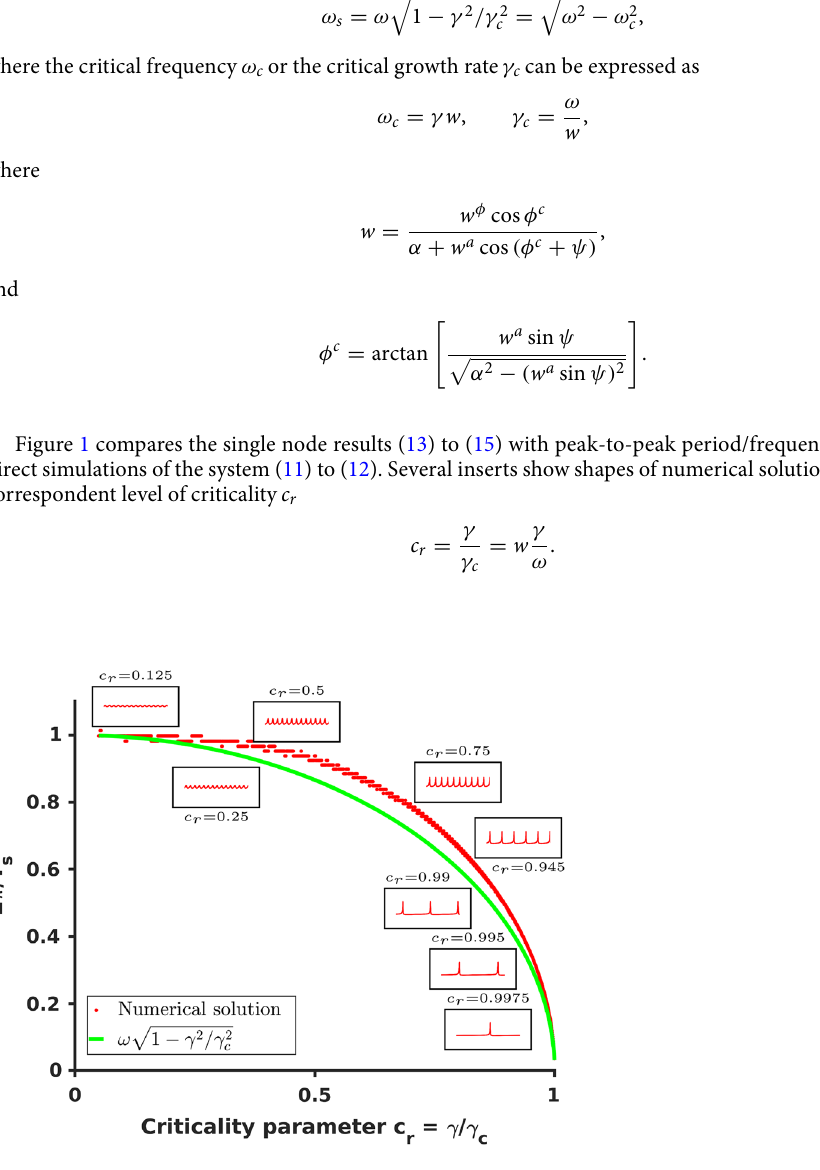
Figure 1. Plot of the analytical expression (14) for the effective spiking frequency ω s = 2 π/ T s (green) and the frequency estimated from numerical solutions of (11) and (12) (red) with several inserts showing the numerical solution with indicated value of the criticality parameter c r = γ/γ c (detailed plots of numerical solutions used for generating inserts are included in “Appendix”). In the numerical solution only γ was varied and the remaining parameters were the same as parameters reported in 62